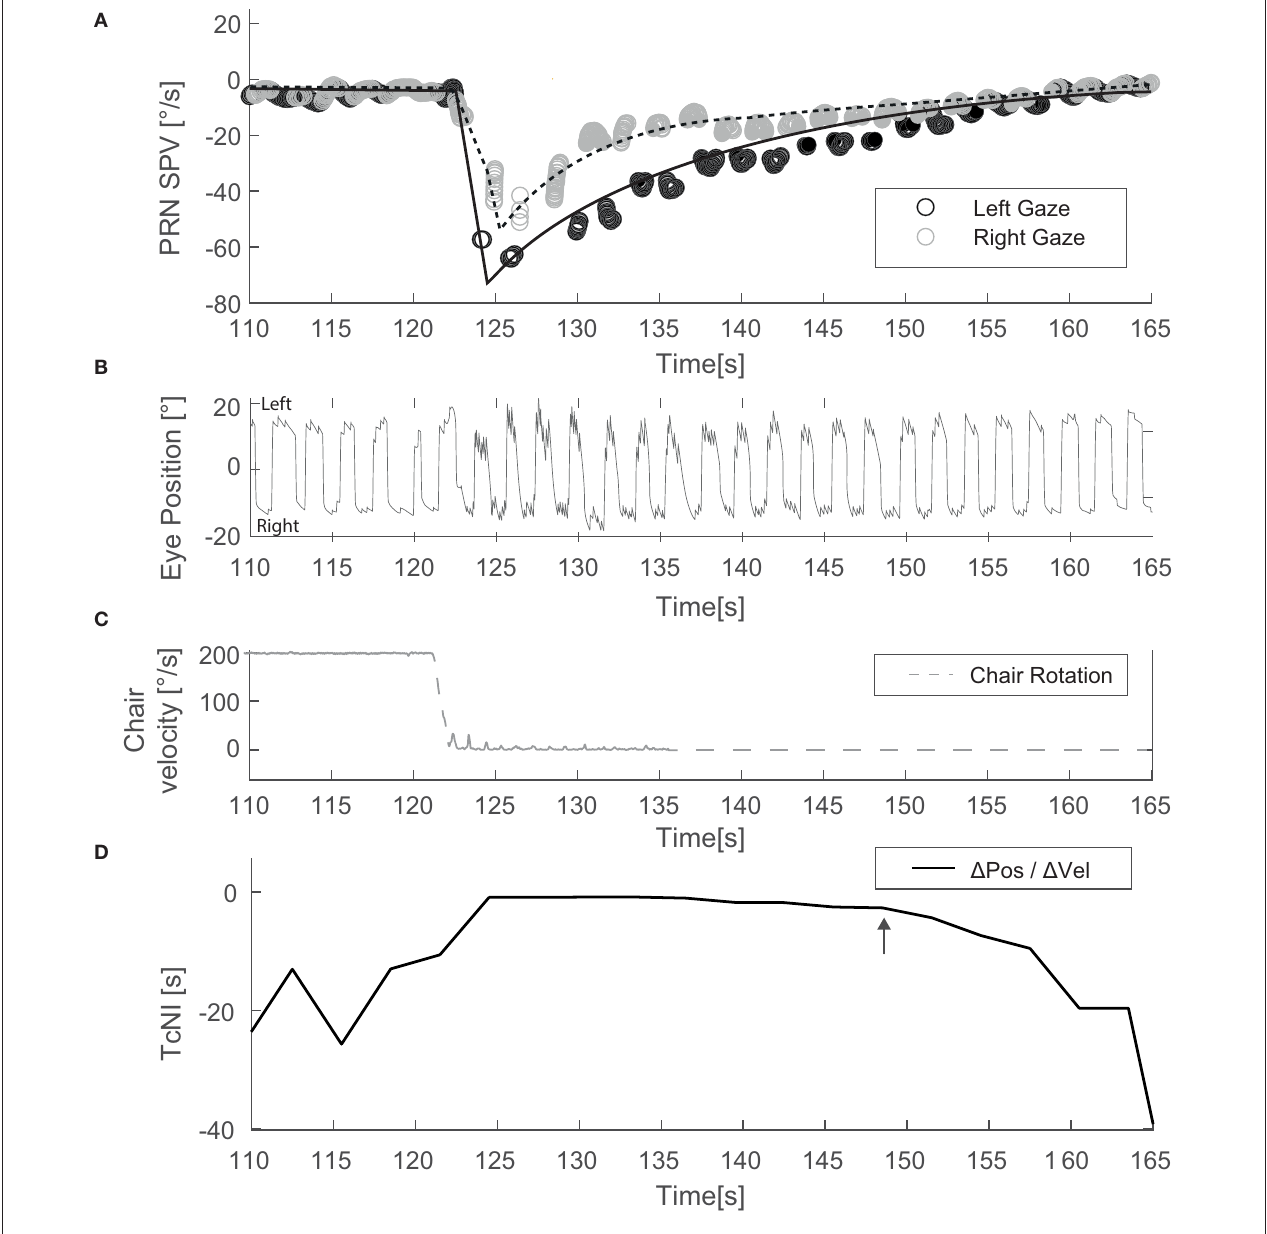
FIGURE 2 | Example of an experiment with the head upright and alternating horizontal gaze (Condition Figure 1A ). (A) Depicts SPV over time just before and after the chair has stopped. (B) Illustrates the corresponding eye position data. (C) Shows the rotational stimulus used (chair velocity). (D) Shows TcNI as a function of time. The arrow indicates the estimated point when the TcNI began to recover toward normal.